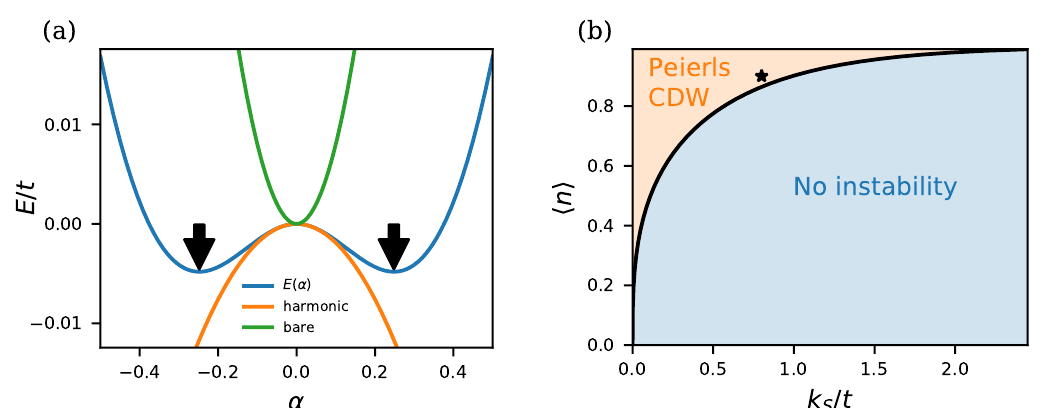
/ t = 0.8, 〈 n 〉 = 0.9. The curves show the exact energy Figure 2: (a) Energy landscape at k s E ( α ) , the harmonic approximation including electronic screening E ( 0 )+ 1 ω 2 α 2 . The arrows indicate the minima at ± α ∗ . (b) Phase phonon energy E ( α = 0 ) + 1 2 bare diagram of the SSH model for the density 〈 n 〉 and the force constant k the parameters of (a). We only consider the transition to the dimerized